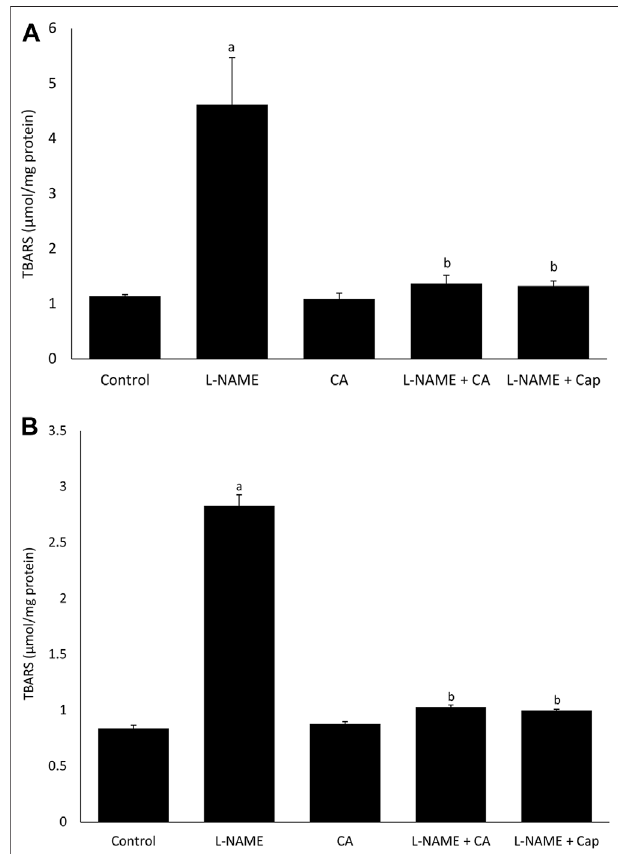
FIGURE 5 | The effects of C. asiatica (500 mg/kg orally) and captopril (5 mg/kg orally) on (A) aortic and (B) cardiac TBARS content in L -NAME- administered rats (40 mg/kg orally) after 8 weeks. Bars represent mean ± SEM ( n (cid:1) 6). a versus control ( p < 0.05), b versus L -NAME ( p < 0.05).